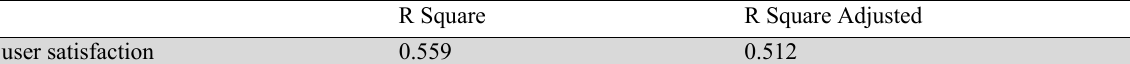
R Square R Square Adjusted